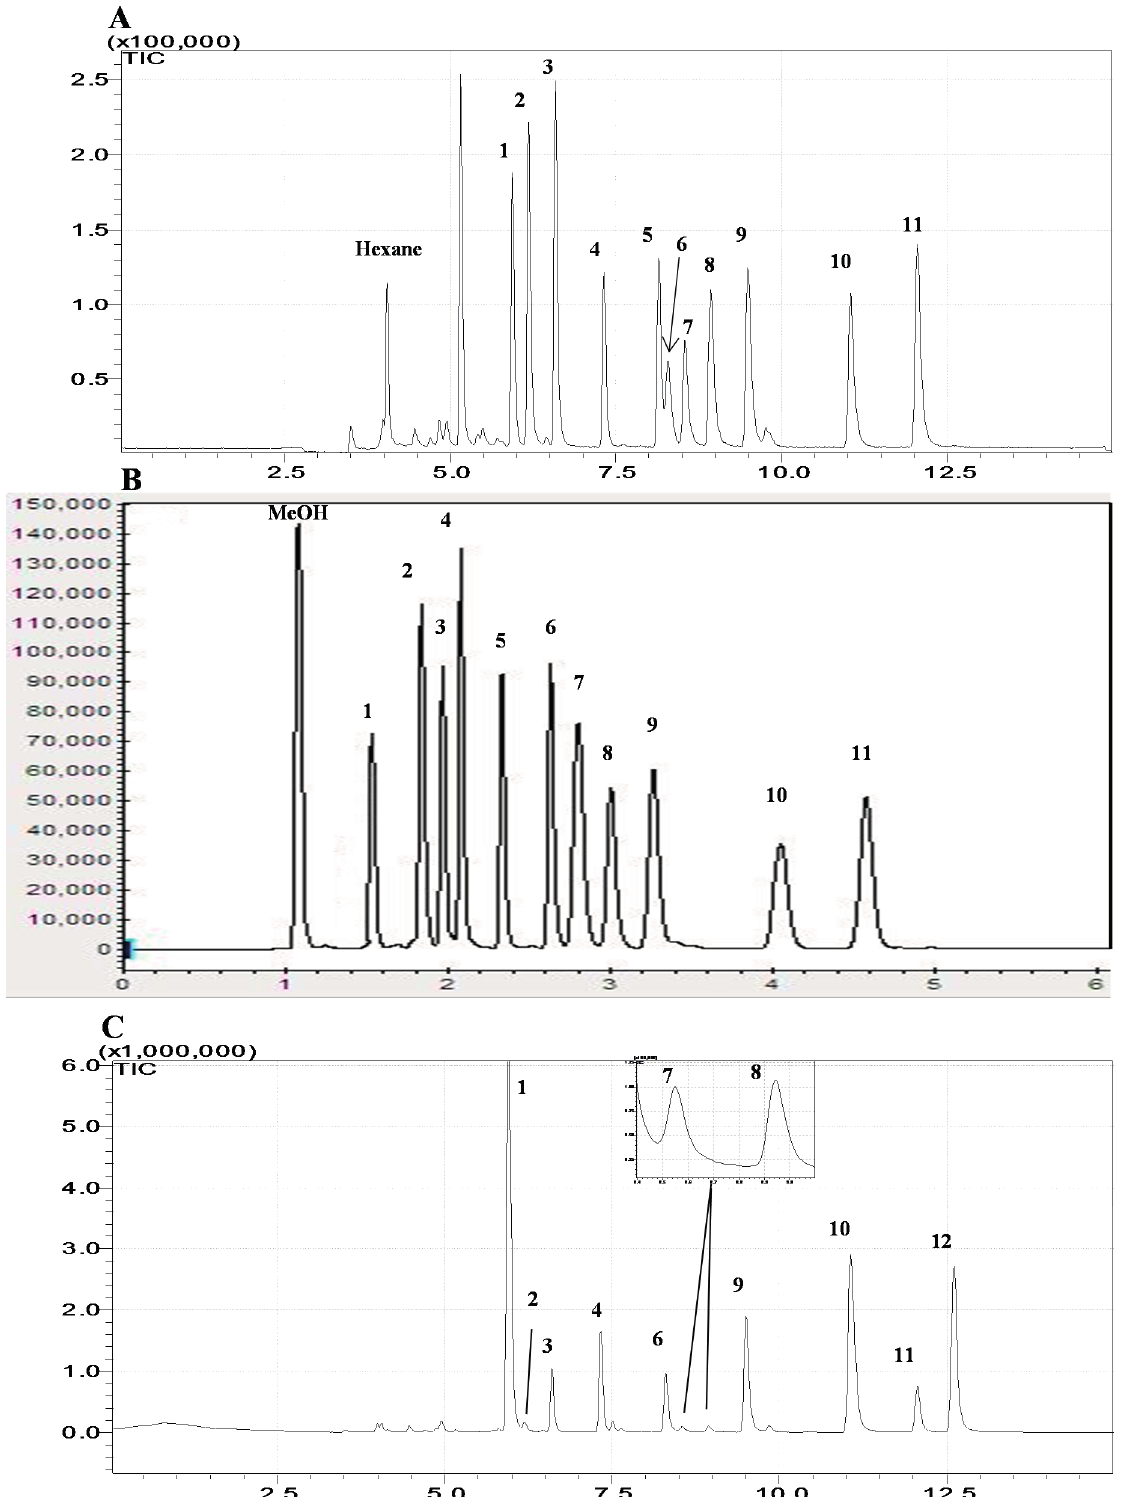
Figure 4. Representative chromatograms of MTs obtained by ST/TD/GC system: ( A ) L-WS of 10 ng (MS); ( B ) L-WS of 50 ng (FID); and ( C ) 250 mL headspace sample of carrot (MS) with the peak ID: α -pinene (1), toluene (2), camphene (3), β -pinene (4), 3-carene (5), myrcene (6), α -phellandrene (7), α -terpinene (8), p -cymene (9), R -limonene (10), γ -terpinene (11), and α -Terpinolene